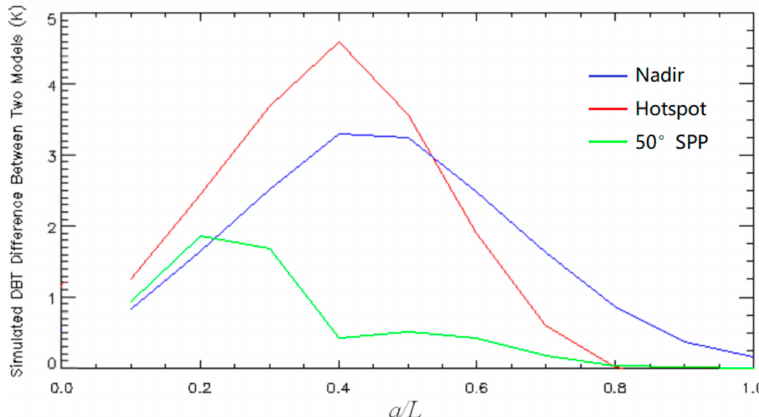
Figure 8. Directional brightness temperature ( DBT ) simulation di ff erence between the new model and Yu model changes with row structure configurations.